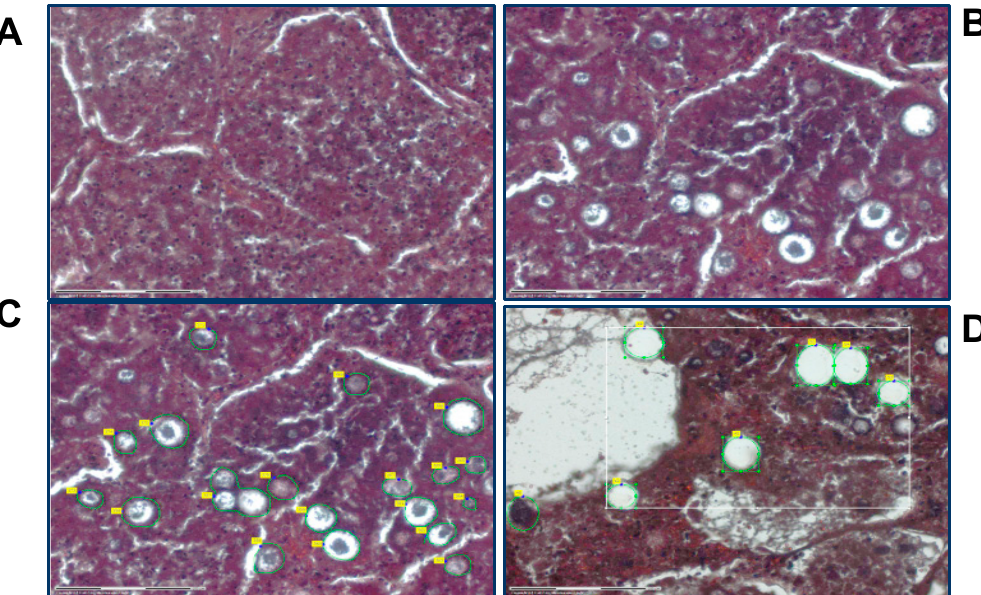
Figure 1. Laser capture microdissection (LCM) of Coccidioides spp.-infected human lung tissue is able to precisely extract spherules. Clear (white) circles rimmed with green and with yellow boxes indicate areas where spherules were laser-captured. Tissue sections without fungal spherules ( A ) can be ignored, whereas sections with spherule elements ( B ) can be selected ( C ) and exclusively removed ( D ).